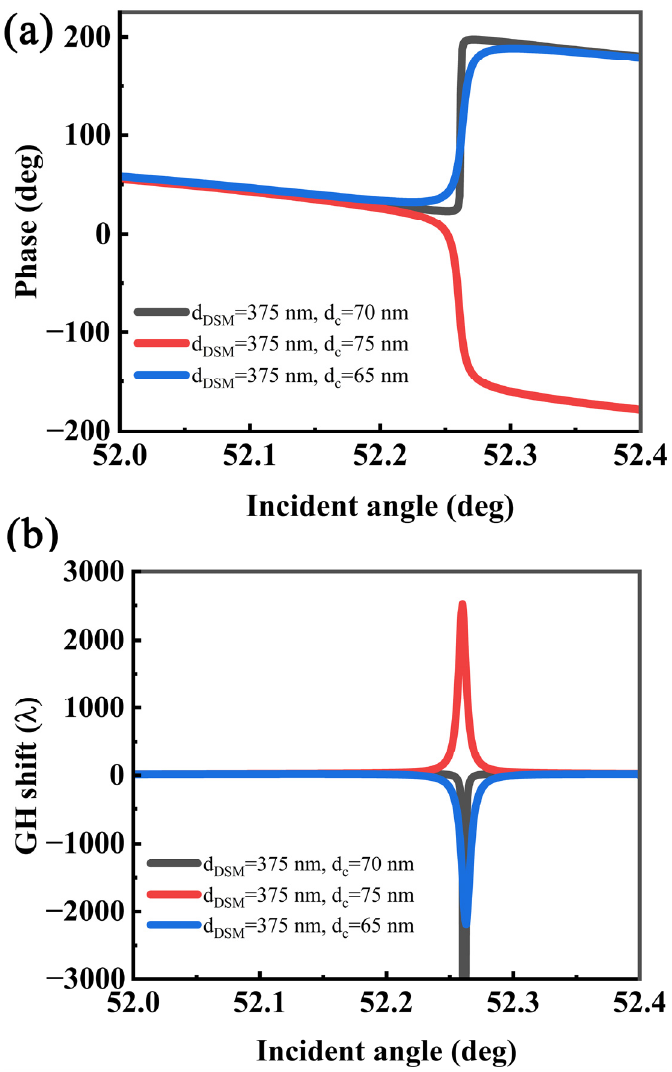
Figure 6. Calculated ( a ) phase and ( b ) GH shift as a function of the incident angle with different coupling layer thicknesses.